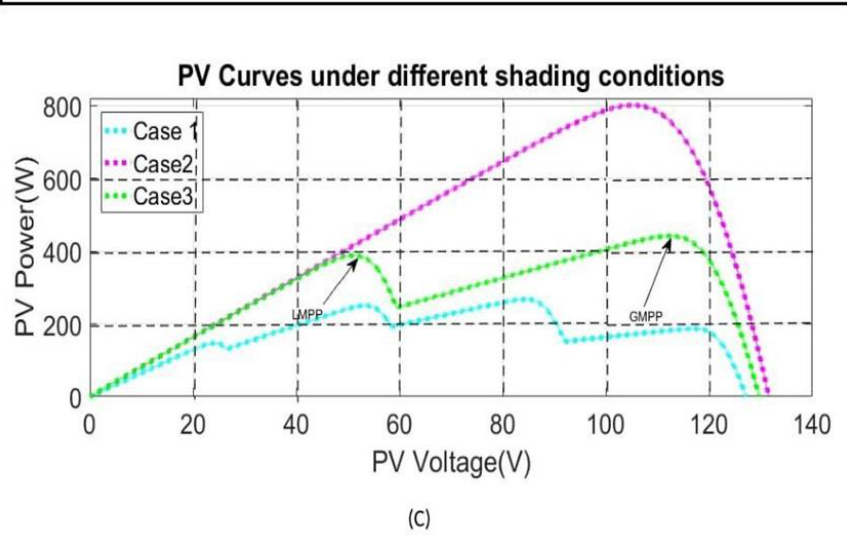
Figure 8. 4S Arrangement under various shading patterns. ( a ) Pattern 1. ( b ) Pattern 2. ( c ) P-V characteristics of a solar PV system at different shading conditions.